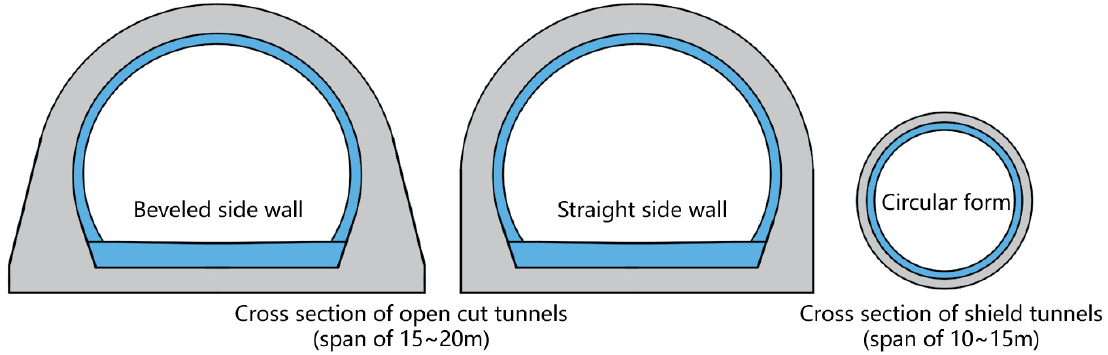
Figure 2. Comparison of size and shape of open-cut and shield tunnels using the bilayer design.